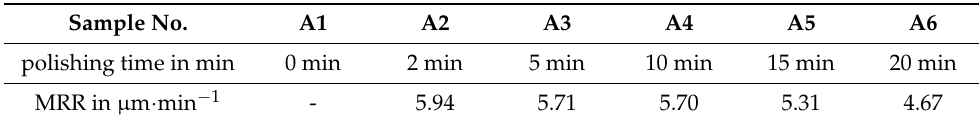
Table 3. Overview over the PeP treatment times for each sample. Sample